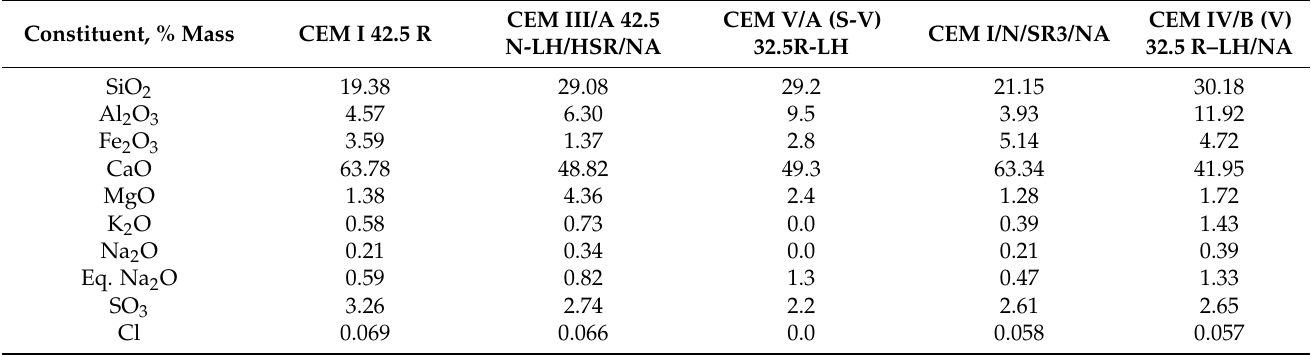
Table 3. Chemical compositions of